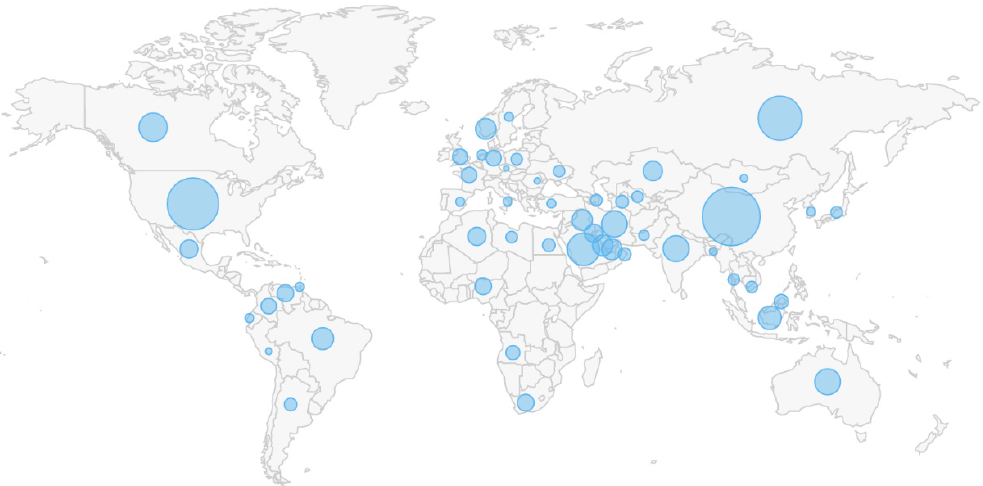
Figure 5. Total energy production, 1980–2017. Source: [79]. Global energy production. Available online: https://www.eia.gov/international/data/world/other-statistics. accessed on 10 December 2020.